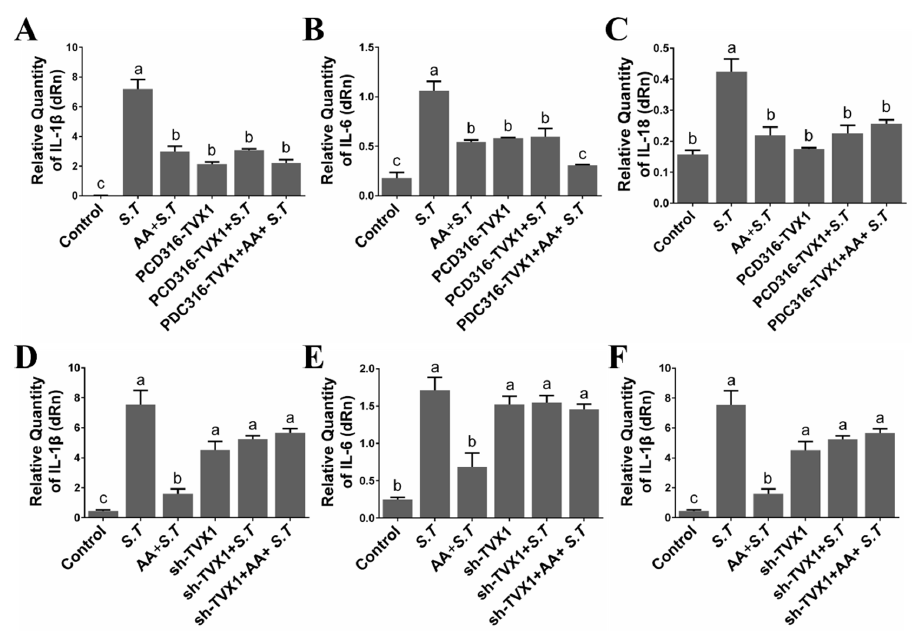
Figure 4. Effect of LncRNA TVX1 on AA Activation of Inflammatory Factors in S.T -infected Micro- ( A – C ) Effect of lncRNA TVX1 overexpression plasmid PCD316-TVX1 on expression of S.T